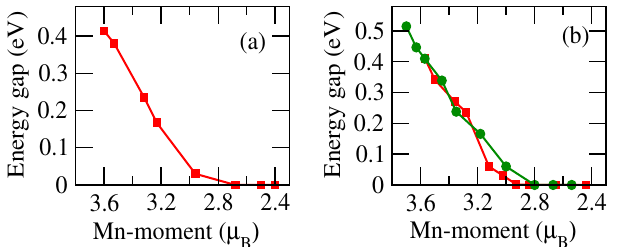
Figure 7. Variation of the energy gap at the Fermi level at different fixed Mn magnetic moments for ( a ) ThMnAsN and ( b ) ThMnPN (green circles indicate the energy gap at various fixed Mn magnetic moments with an effective Hubbard U of 0.9 eV) with the C-AFM spin